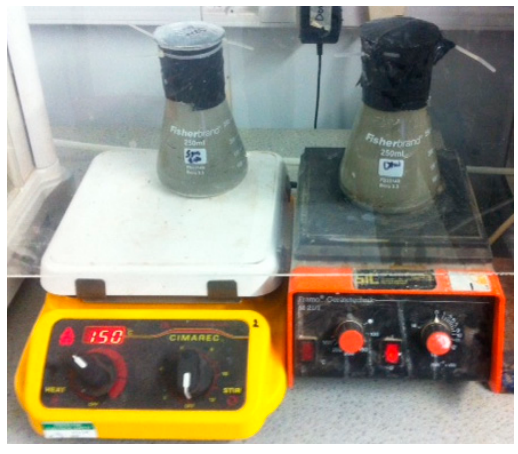
Figure 1. Heated thermo-saline-corrosion exposure samples.